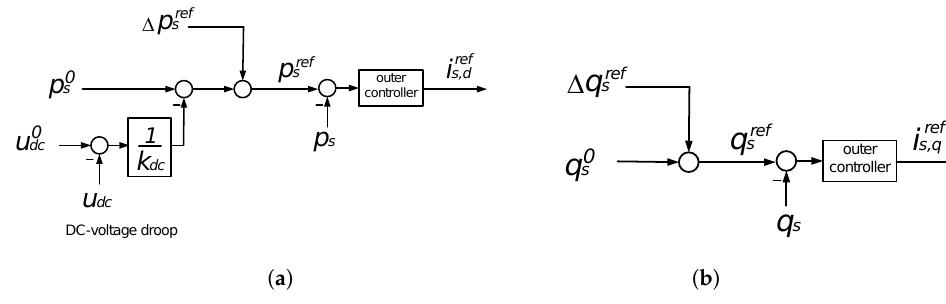
Figure 3. ( a ) P control and ( b ) Q